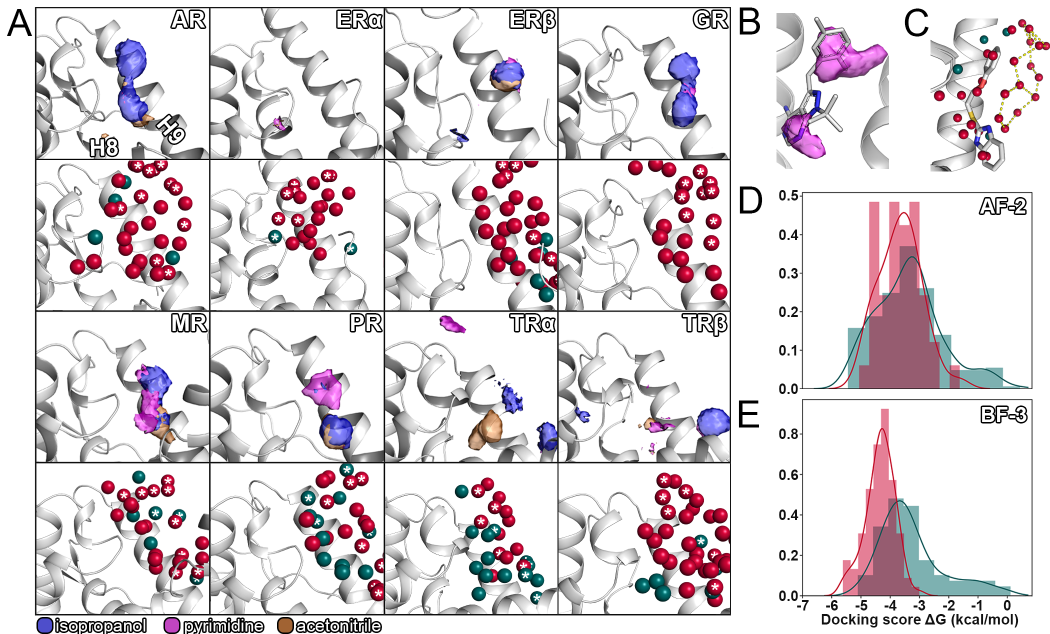
Figure 3. Results from cosolvent simulations, hydration site prediction for the BF-3 site, and molecular docking. ( A ) For each receptor, the results of cosolvent simulations (upper part) and hydration site prediction (lower part) from WATsite for the AF-2 site are given. The color scheme for the cosolvent densities is given below the figure. The densities are shown at an isovalue of 12. Water molecules, that were found to be conserved based on a crystal structure analysis were colored in pine green and water molecules with a negative enthalpy ( ∆ H < − 1.0 kcal/mol) were indicated with asterisks. ( B ) Density of pyrimidine at the AF-2 overlapping with cocrystallized ligand (PDB ID: 2PIP). ( C ) Cluster of water molecules at the BF-3 of the androgen receptor (AR). A cocrystallized ligand molecule is shown for comparison (PDB ID: 4HLW). Polar contacts were visualized in PyMol. ( D ) Distribution of docking scores of AR AF-2 inhibitors. Confirmed actives are shown in red, while the remaining compounds of the library are colored pine green. ( E ) Distribution of docking scores of AR BF-3